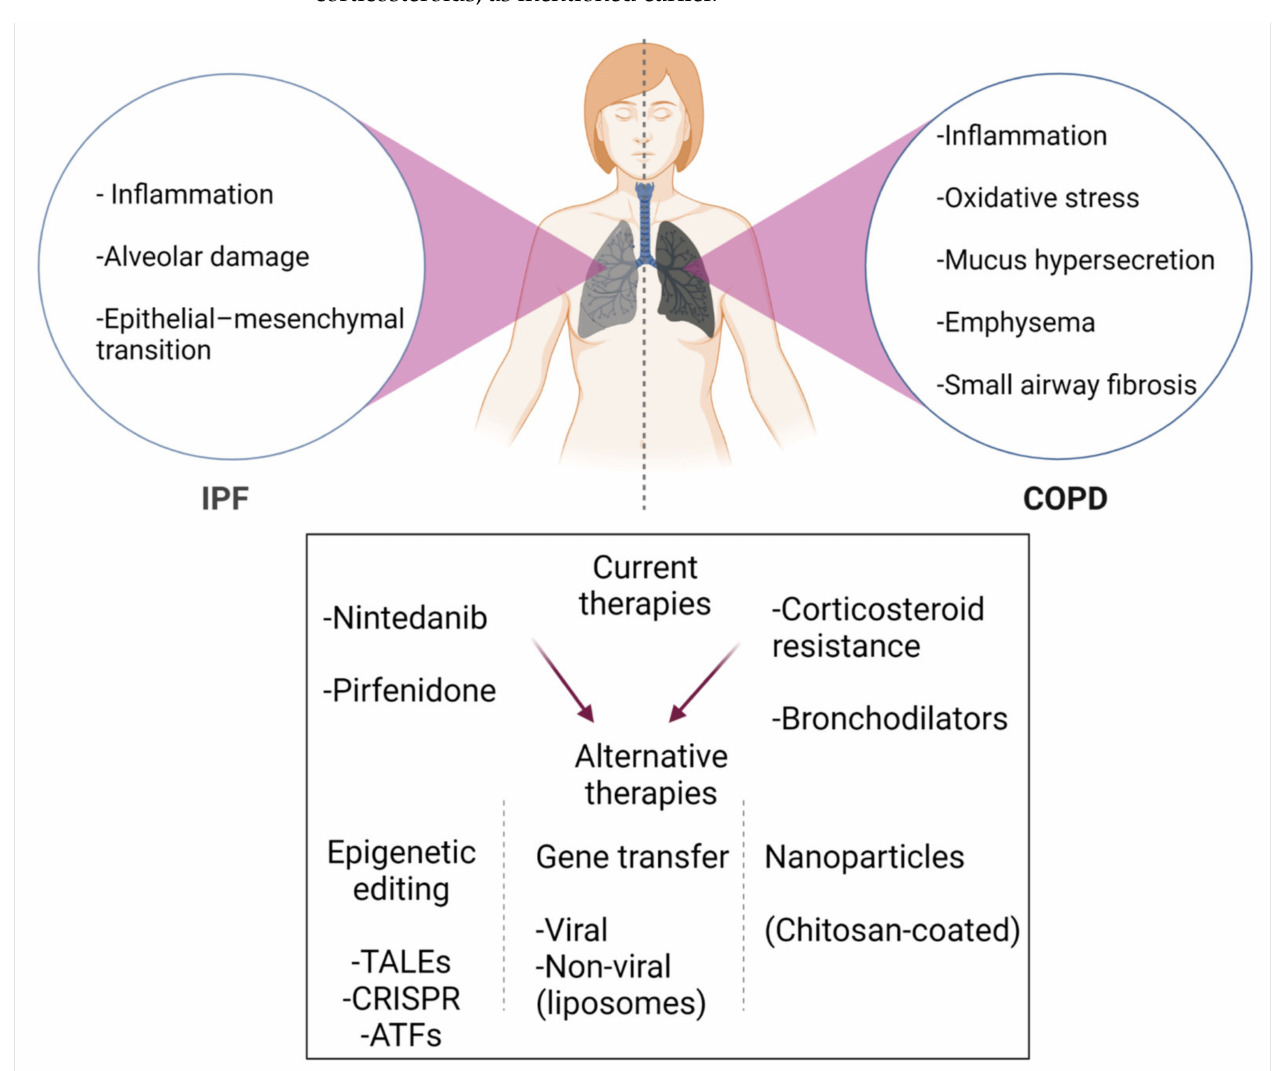
Figure 3. Brief schematic summary of current medications and new strategies for IPF and COPD treatment. Since current drugs and therapies do not show curative effects, new approaches for patients (depicted by red arrows) are required. In addition, large numbers of COPD patients are resistant to corticosteroids. To improve the current therapeutic options in IPF and COPD, a considerable shift in efforts towards epigenetic editing, gene transfer, and nanoparticles in the research field. Figure created using BioRENDER.com. Accessed on 18 November